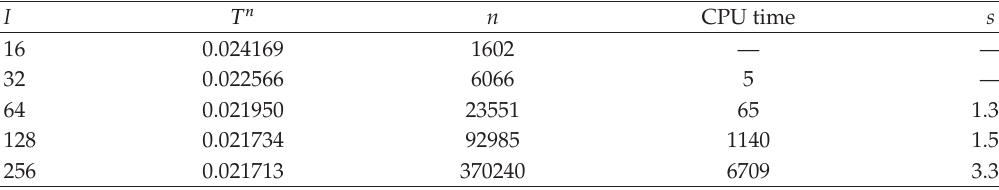
Table 6: Numerical blow-up times, numbers of iterations, CPU times (cid:3) seconds (cid:4) and orders of the approximations obtained with the implicit Euler method defined in (cid:3) 10.2 (cid:4)